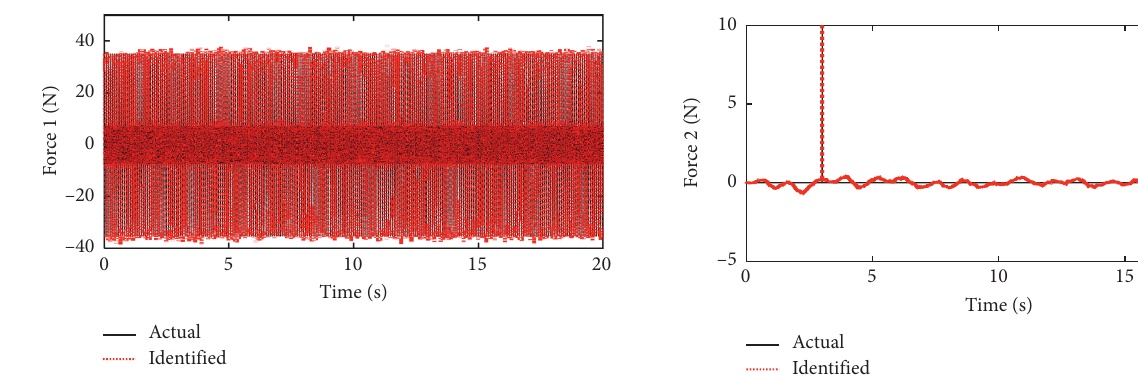
Figure 7: Identification of external load u